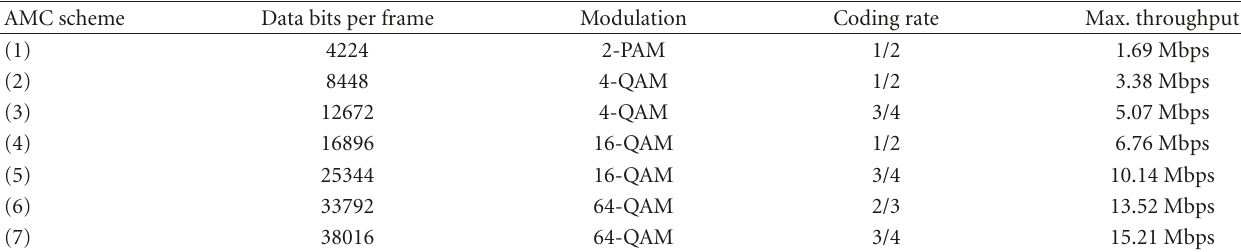
Table 1: The WiMAX AMC schemes in our setup for single antenna and Alamouti transmission. For spatial multiplexing, a separate AMC scheme can be used for every transmit antenna. These frame sizes correspond to 44 OFDM data symbols transmitted in a frame duration of 2.5